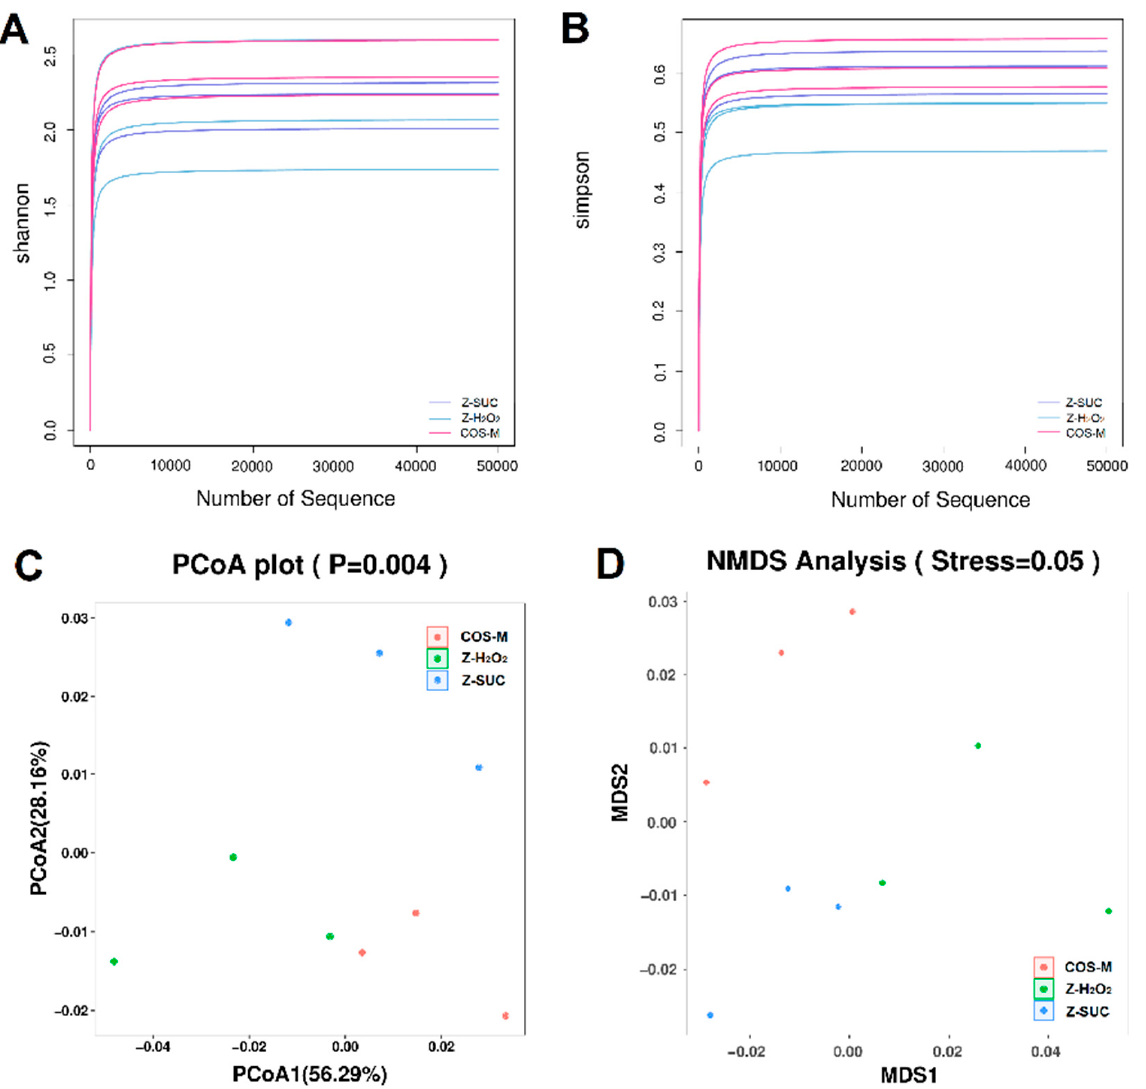
Figure 7. Analysis of alpha diversity and beta diversity of the intestinal microbiota: ( A ) Shannon index, ( B ) Simpson index, ( C ) principal co-ordinate analysis (PCoA), and ( D ) nonmetric multidimensional scaling (NMDS) analysis.